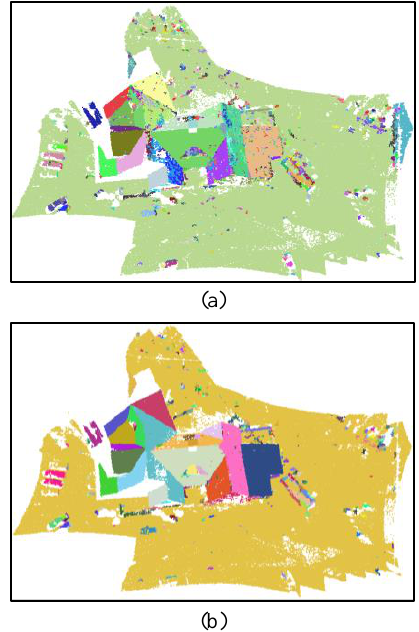
Figure 5. The segmented point (a) before quality control procedure and (b) after quality control procedure